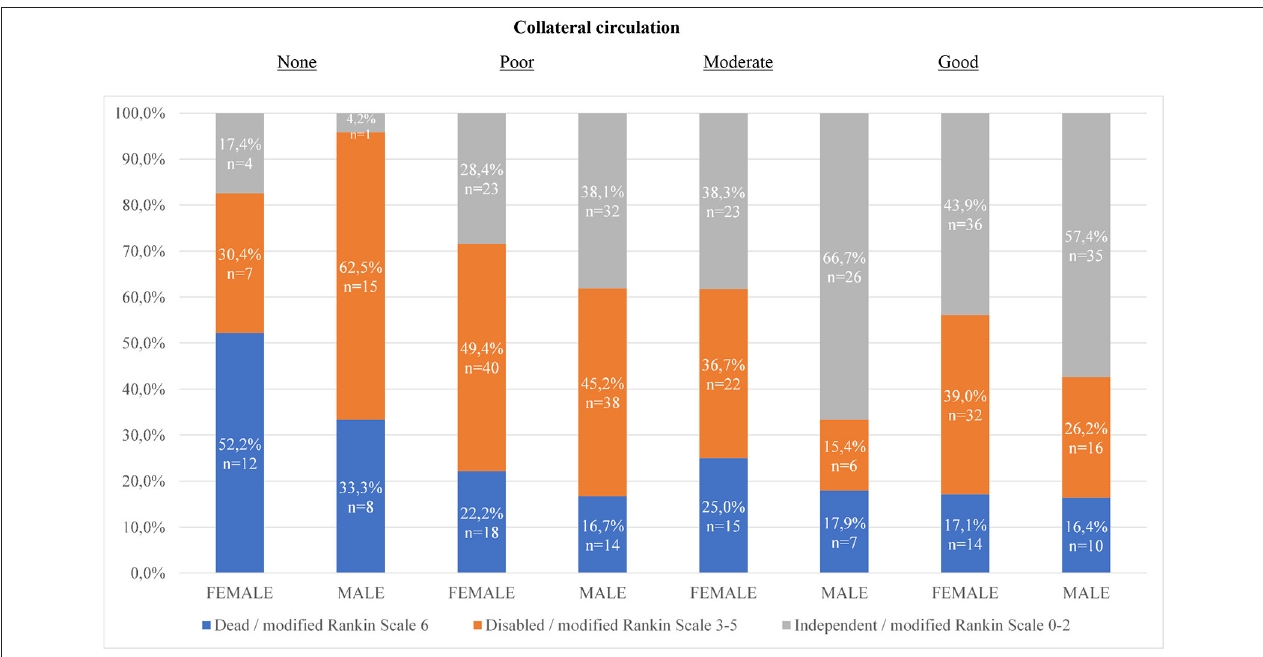
FIGURE 1 | Distribution of functional outcomes 90 days after mechanical thrombectomy for different degrees of collateral circulation. Chi 2-test for sex differences in proportion of functionally independent outcome: 1. ( p = 0.14) 2. ( p = 0.19) 3. ( p = 0.01) 4. ( p = 0.11) For dichotomization moderate and good collaterals together ( p = < 0.01). For dichotomization none and poor collaterals together ( p =